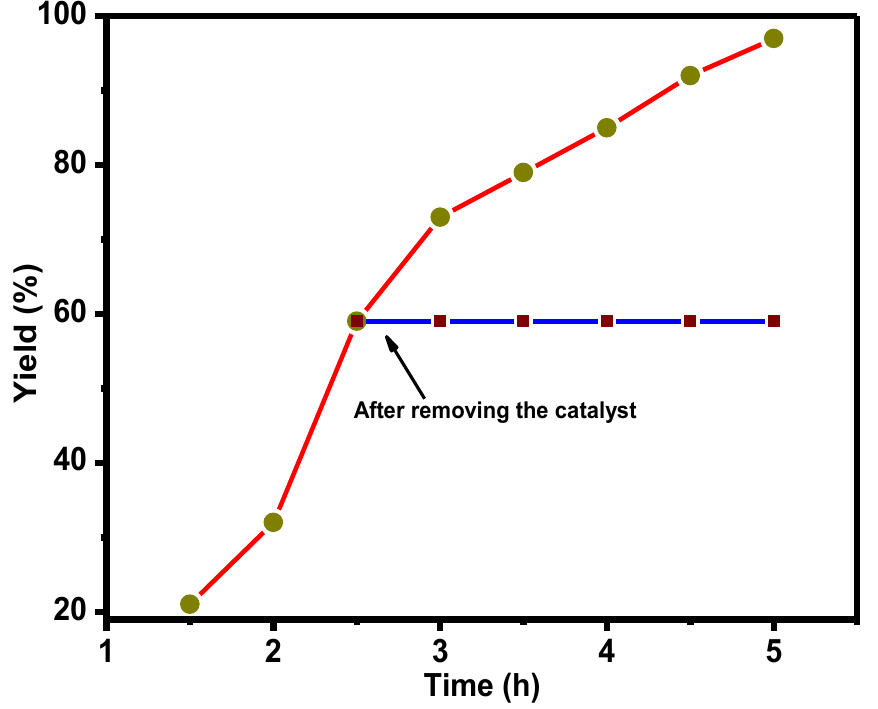
Figure 9. The test to determine homogeneous catalysis contribution in the C-C coupling reaction by 5 Cu(0)-AAPTMS@RGO-MCM-41 a . a The line connecting red squares shows the yield of biphenyl as a function of reaction time in the presence of 5Cu(0)-AAPTMS@RGO-MCM-41. The line connecting blue stars indicates the yield of biphenyl after the removal of the catalyst . In heterogeneous catalysis, the material’s recyclability is paramount, and it is contin- gent primarily on the stability of the catalyst. The activity of catalyst materials can decline due to the leaching effect of the active metal or the agglomeration of the metal particles. For robustness, the recovered catalyst was reused after regeneration by calcination. Up to the fourth cycle, the yield of the product has not changed. The active metal particle did